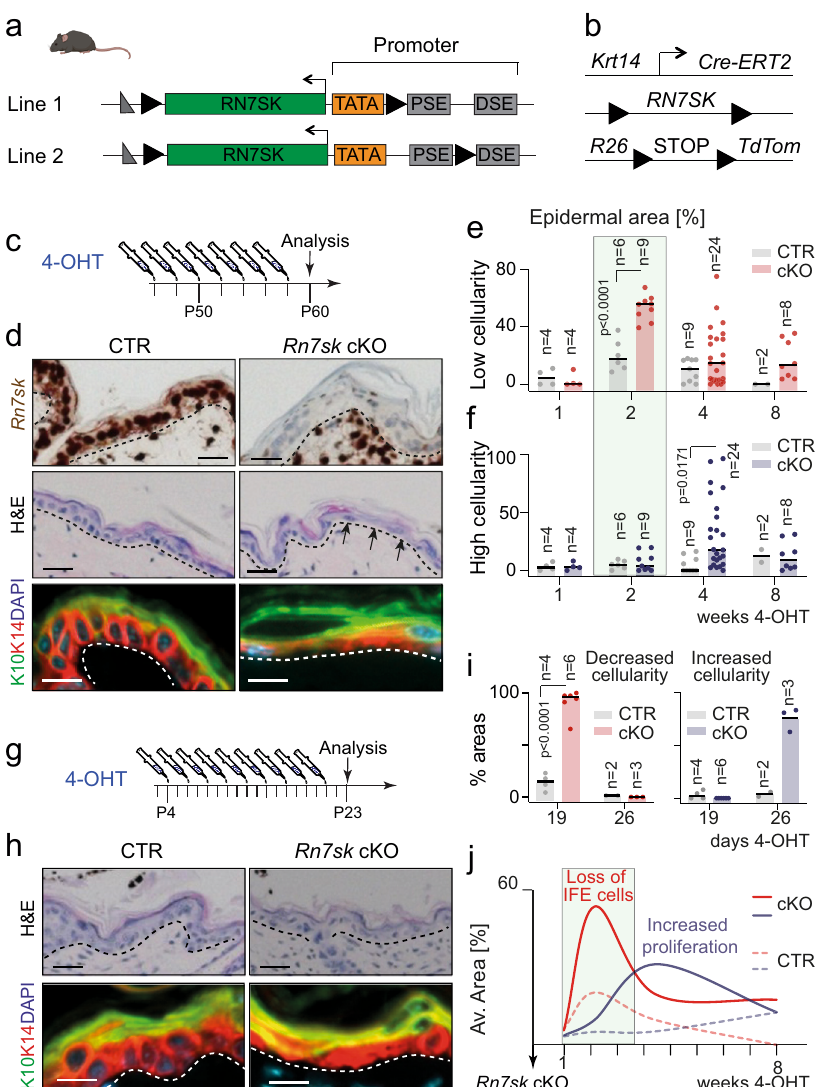
Fig. 1 Rn7sk regulates cellularity in the mouse epidermis. a Schematic representation of the targeted Rn7sk alleles in the two mouse lines generated. loxP sites = black triangles; TATA = TATA box; PSE = proximal sequence elements; DSE = distal sequence elements. b Schematic representation of the transgenes used to delete Rn7sk within the interfollicular epidermis (IFE). c Treatment regime of the experiment shown in ( d ). d Rn7sk RNA in situ hybridization (brown; top panel), haematoxylin and eosin staining (H&E, middle panel) and KRT10 (K10; green) and KRT14 (K14; red) immuno fl uorescence (bottom panel) of control (CTR) and Rn7sk knock-out ( Rn7sk cKO) mice. e , f Quanti fi cation of skin area with reduced (red) ( e ) or increased (blue) ( f ) epidermal cellularity at the indicated time points ( n = mice). g Treatment regime of the experiment shown in ( h , i ). h H&E staining (top panel) and KRT10 (K10; green) and KRT14 (K14; red) immuno fl uorescence (bottom panel) of mice treated with 4-hydroxytamoxifen (4-OHT) as shown in ( g ). DAPI (blue): nuclear counterstain ( d , h ). i Quanti fi cation of skin area with decreased (red; left panel) or increased (blue; right panel) epidermal cellularity in mice treated as shown in ( g ) ( n = mice). J Graphical summary of the data shown in ( e , f , i ). Mouse line 1 was used in ( d , h , i ). Pooled data from mouse lines 1 and 2 are shown in ( e , f ). Scale bar: 10 μ m ( d , h ). Shown is mean. Multiple two-tailed unpaired t-tests. Exact p -values are indicated. Source data are provided as a Source Data fi